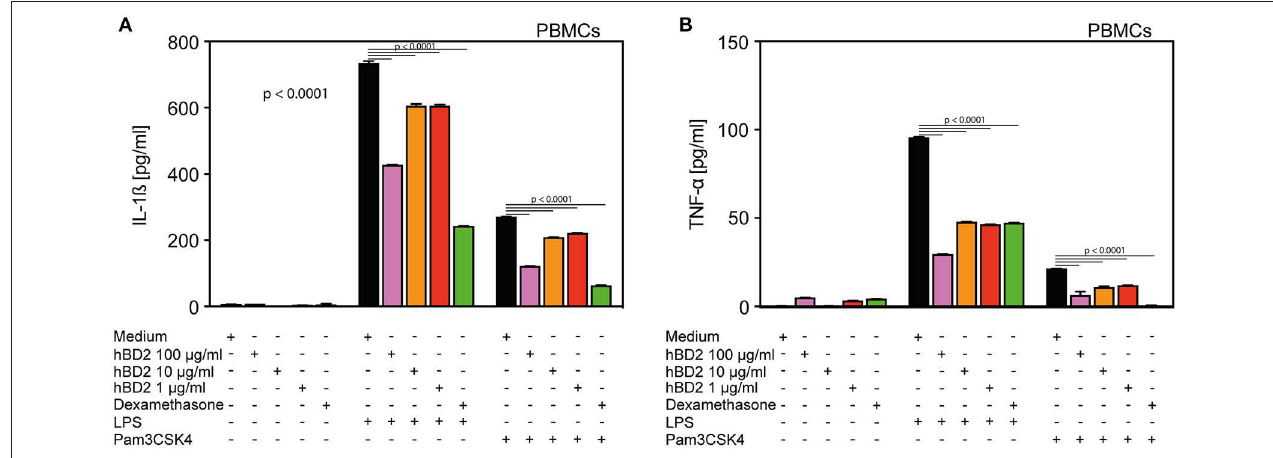
FIGURE 1 | hBD2 reduced the pro-inflammatory effect of LPS and Pam3CSK4 in human primary PBMC’s. PBMC’s were challenged with LPS (20 pg/ml) or Pam3CSK4 (0.3 µ g/ml), respectively, and treated with various concentrations of hBD2 (100, 40, 10, or 1 µ g/ml). Release of (A) IL-1 β and (B) TNF- α . Results are presented as mean ± SEM, (A) and (B) n = 150–194. Statistical analysis was performed by one-way ANOVA with Bonferroni post-test.